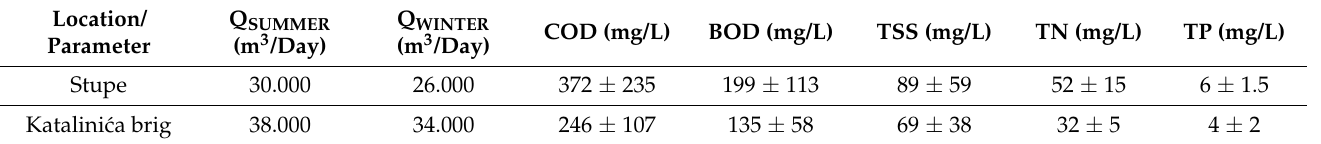
Table 1. Available data for two WWTP locations, considering the average discharge (m 3 /day) and different wastewater effluent parameter concentrations (mg/L), presented as the mean ± standard deviation. Location/Parameter